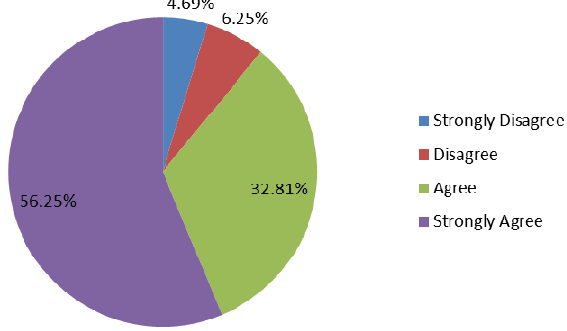
Fig. 5. Crime and corruption affects the growth of the